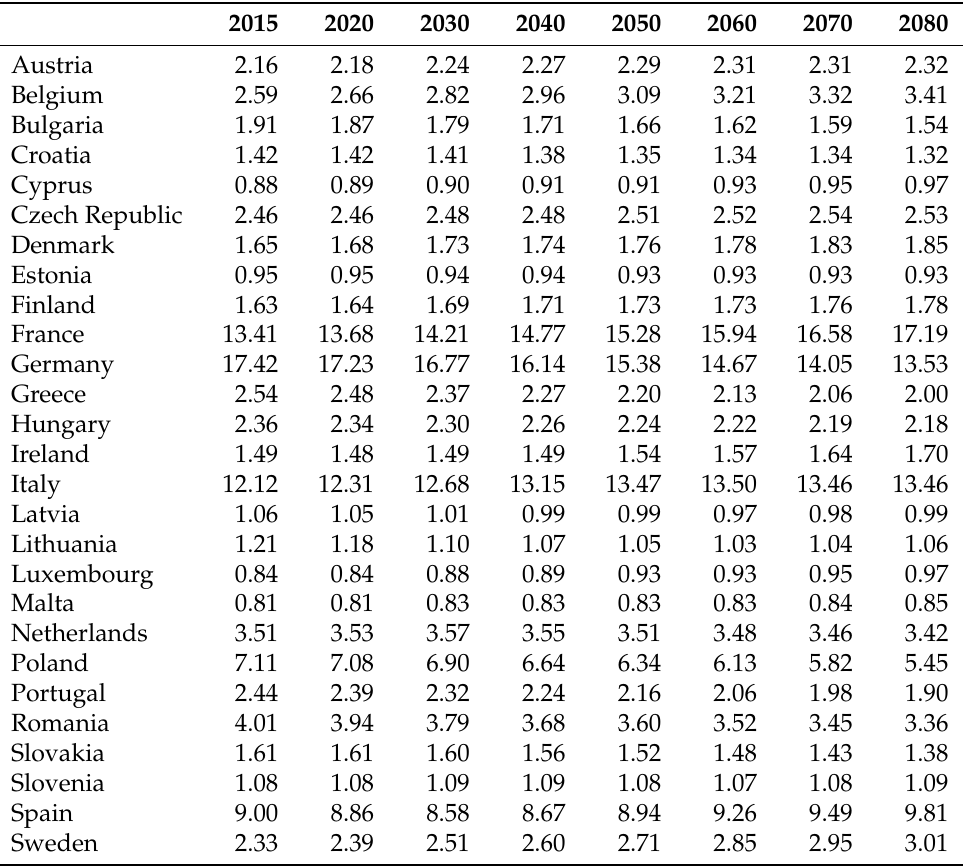
Table A2. Shapley–Shubik index projections after Brexit.